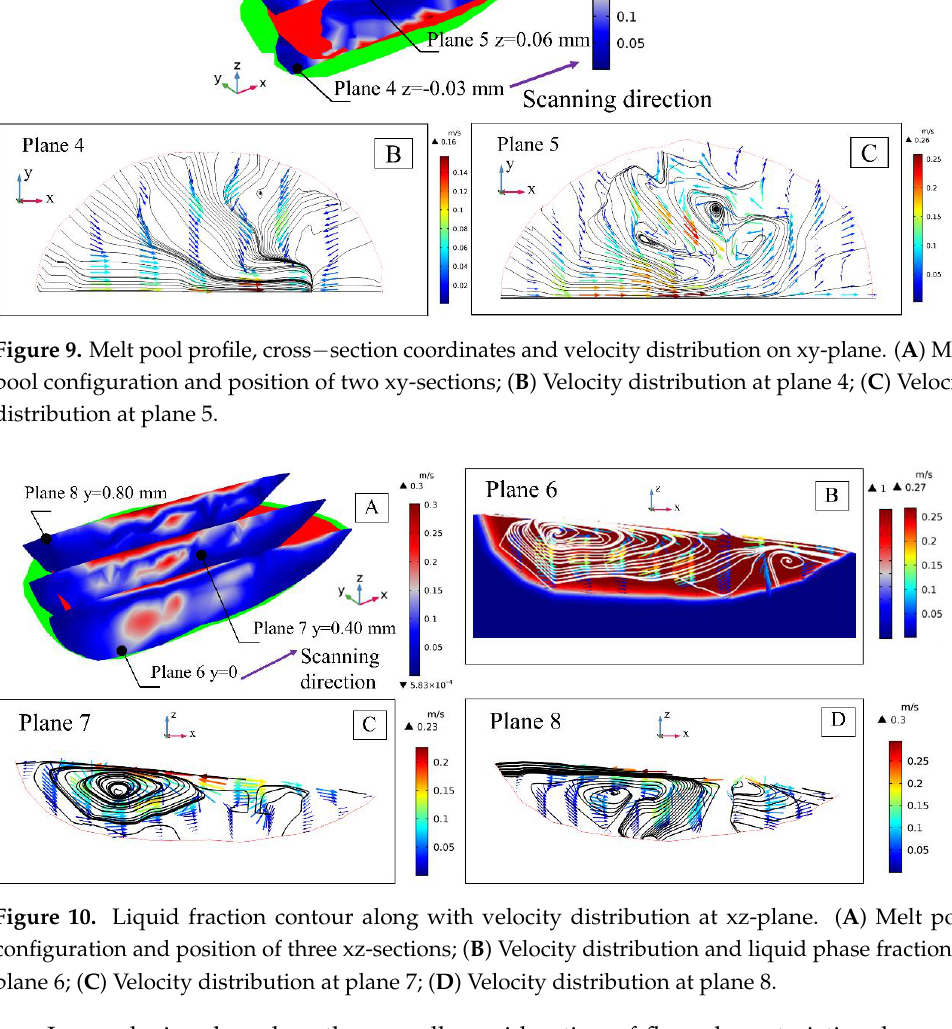
Figure 10. Liquid fraction contour along with velocity distribution at xz-plane. ( A ) Melt pool configuration and position of three xz-sections; ( B ) Velocity distribution and liquid phase fraction at plane 6; ( C ) Velocity distribution at plane 7; ( D ) Velocity distribution at plane 8.